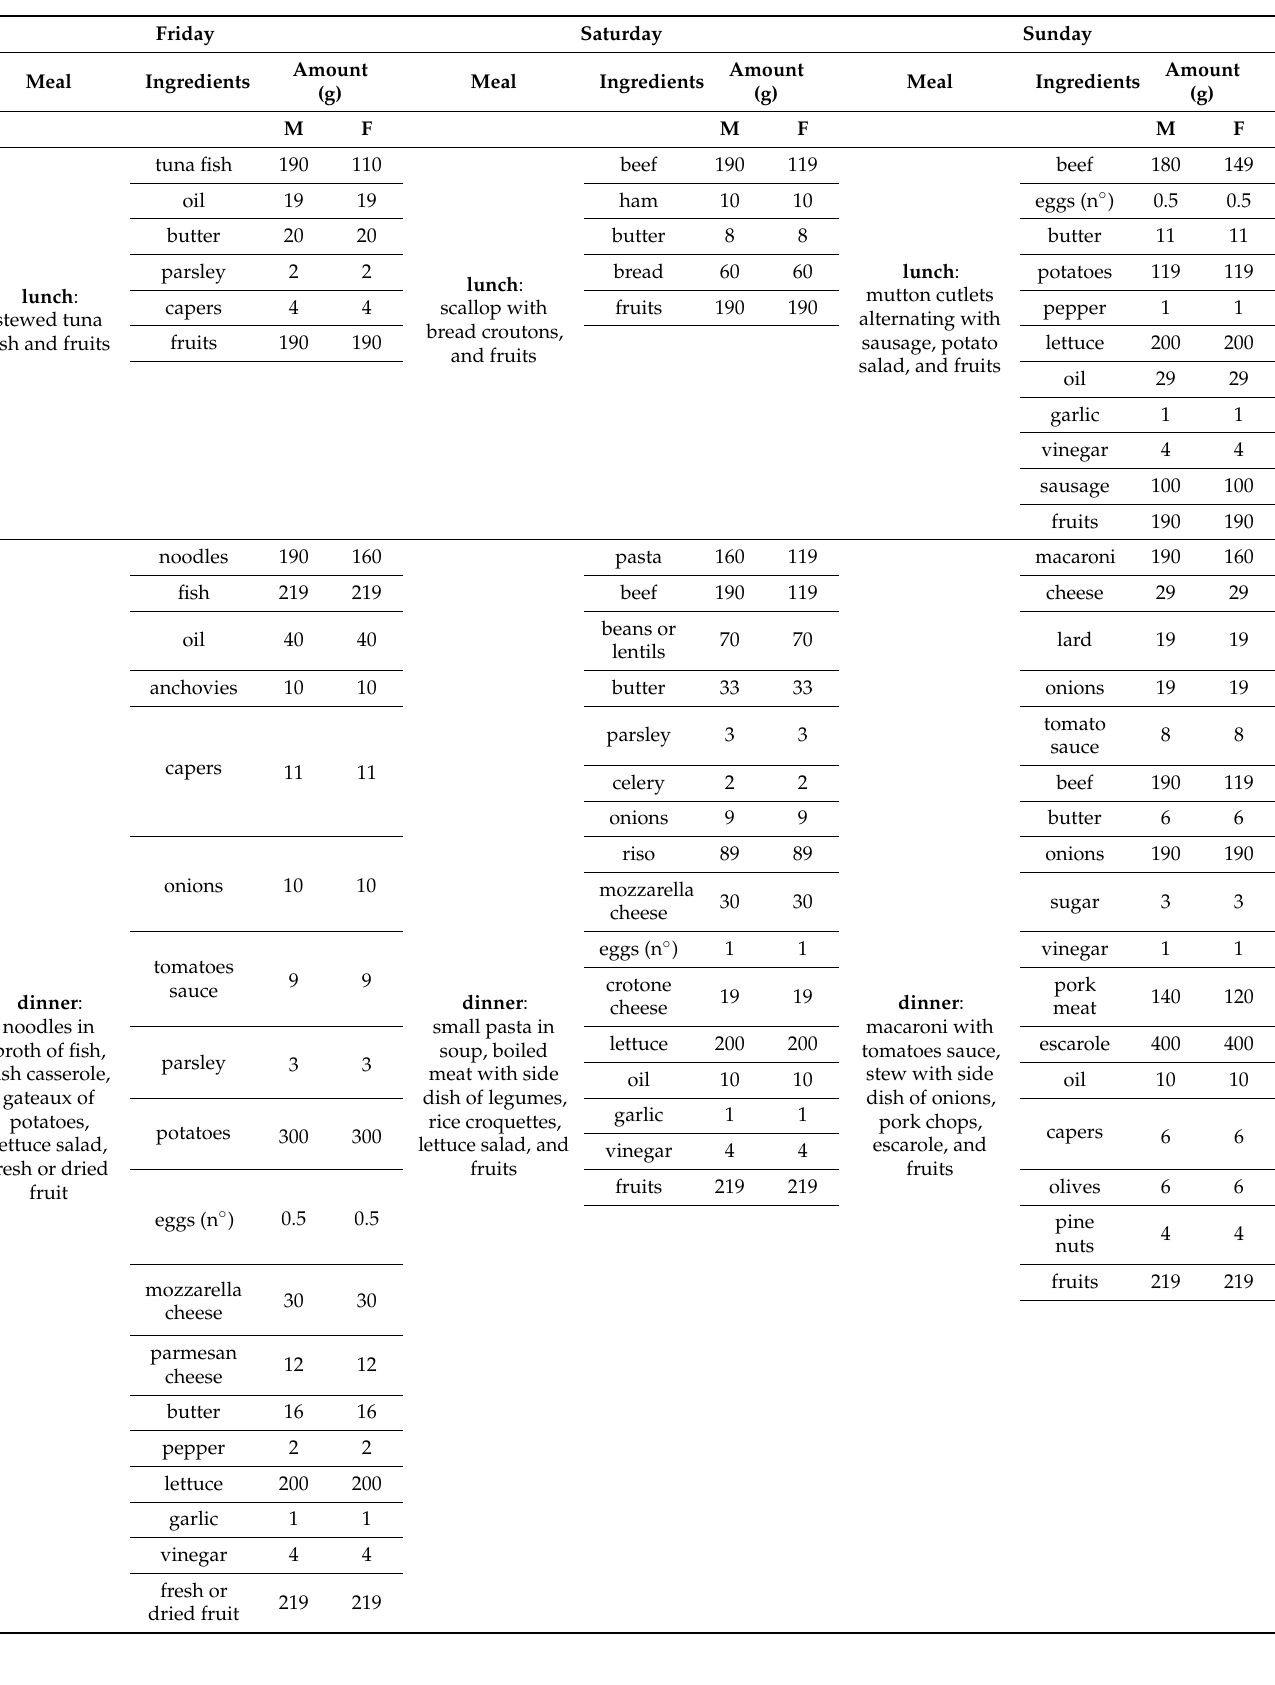
Table 4. Individual meals for 1st and 2nd class patients at lunch and dinner. Months: January, February, November, and December (2)